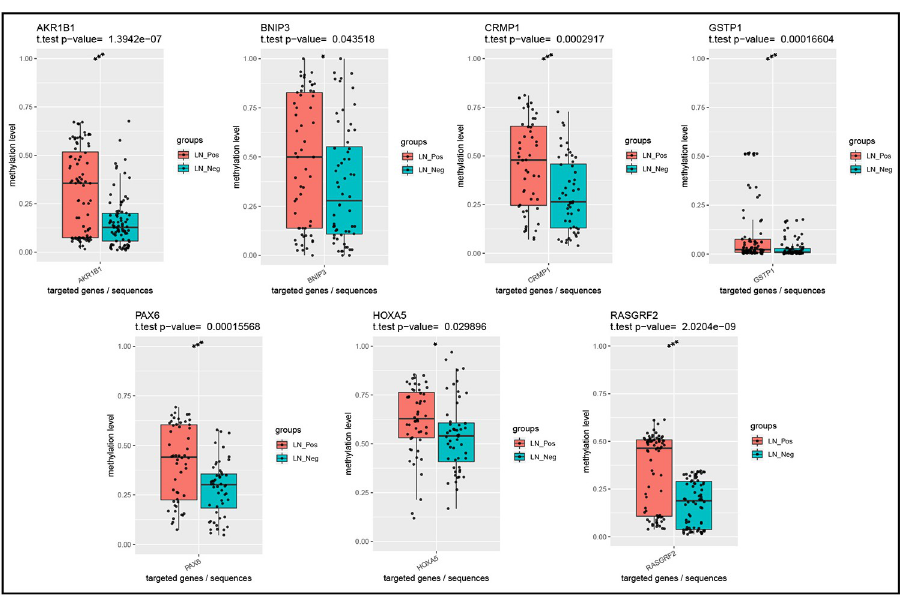
Fig 3. Box plot show differences between ER-positive and HER2-negative breast cancers with and without axillary lymph node metastasis. LN, Lymph node.